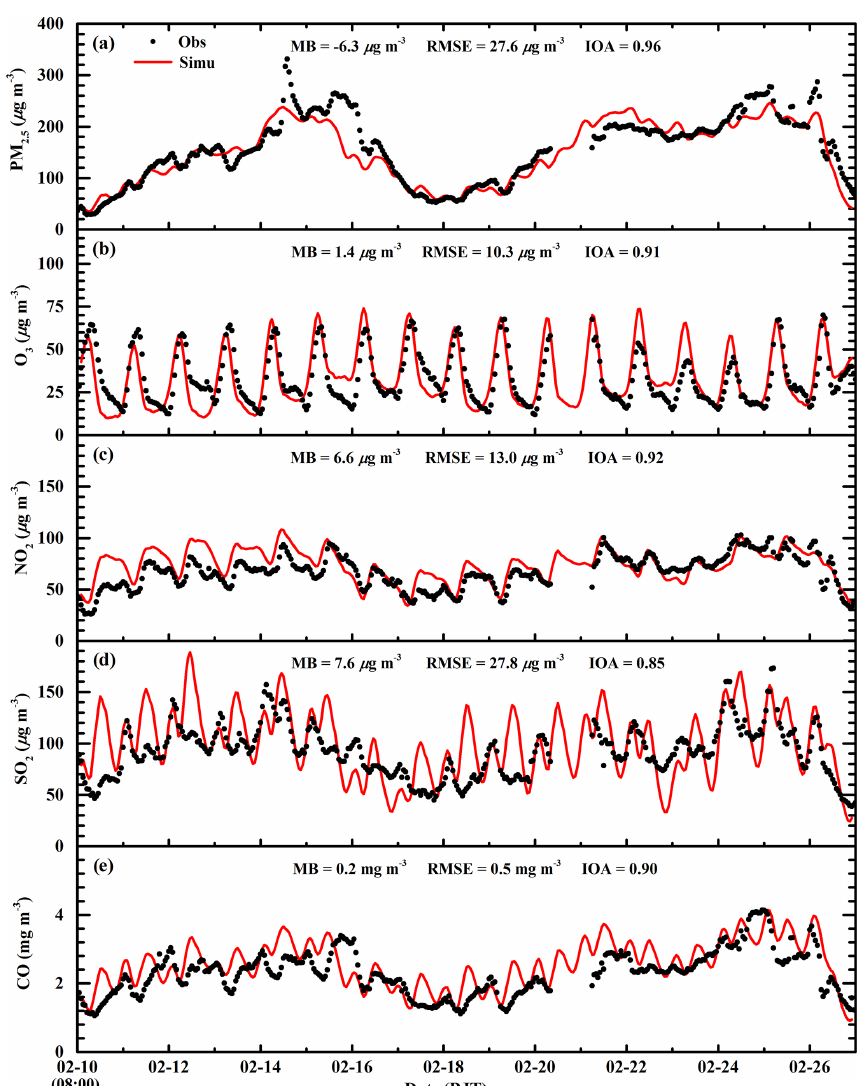
Figure 5. Comparison of observed (black dots) and simulated (red line) diurnal profiles of near-surface hourly (a) PM 2 . 5 , (b) O 3 , (c) NO 2 , (d) SO 2 , and (e) CO averaged over all ambient monitoring stations in BTH from 10 to 27 February